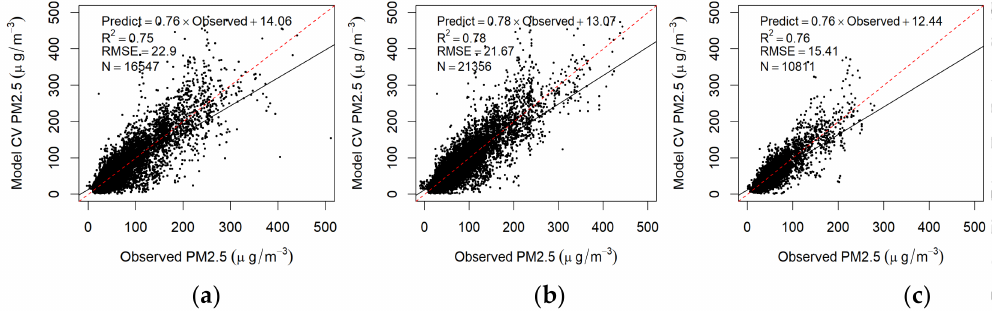
Figure 6. Predicted vs Observed PM 2.5 for cross validation from MAIAC ( a ), DB ( b ) and DT( c )